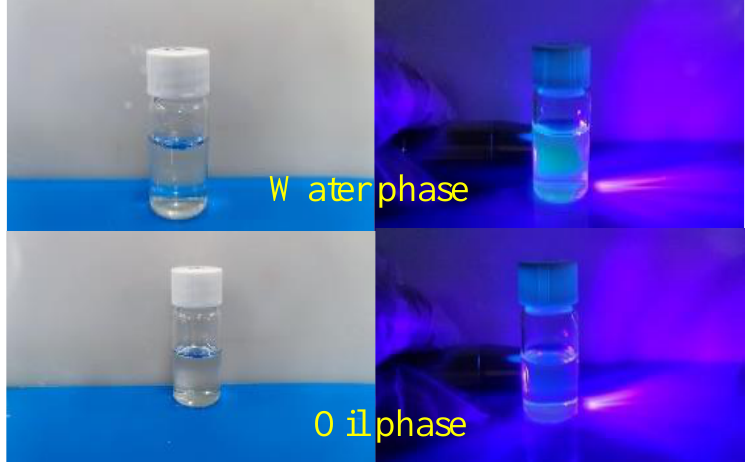
Figure 9. Solution after static stratification.